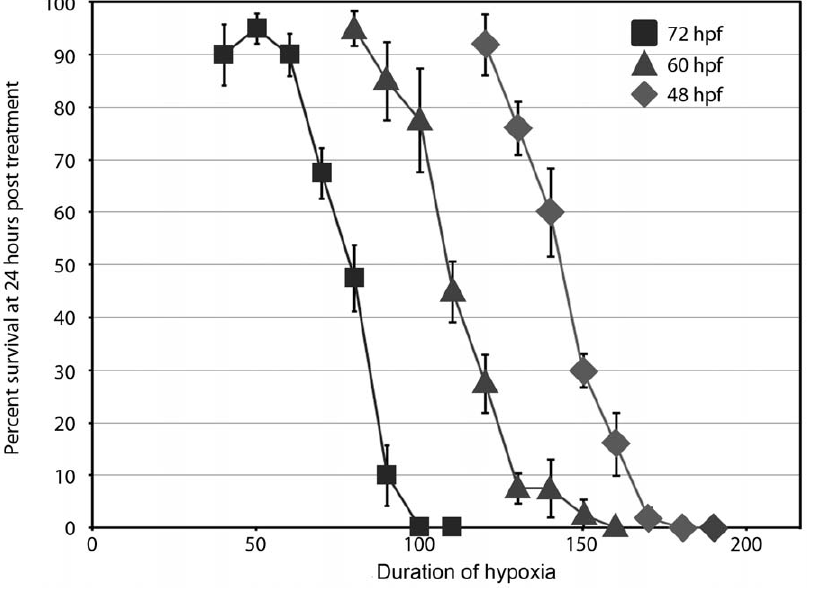
Figure 1. Effects of hypoxia on survival of zebrafish embryos. Zebrafish embryo survival was examined after exposing 48 (diamond), 60 (triangle), and 72 (square) hour-old embryos to hypoxic conditions for the indicated times. Survival was evaluated after 24 hours of recovery in normoxic medium. Data points represent the average percentage of embryo survival in 5 trials. Error bars are the SEM. doi:10.1371/journal.pone.0022268.g001 PLoS ONE |